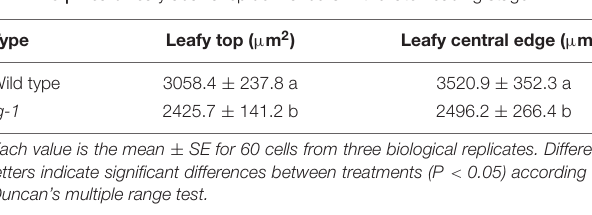
TABLE 3 | Area of leafy adaxial epidermal cells in the late heading